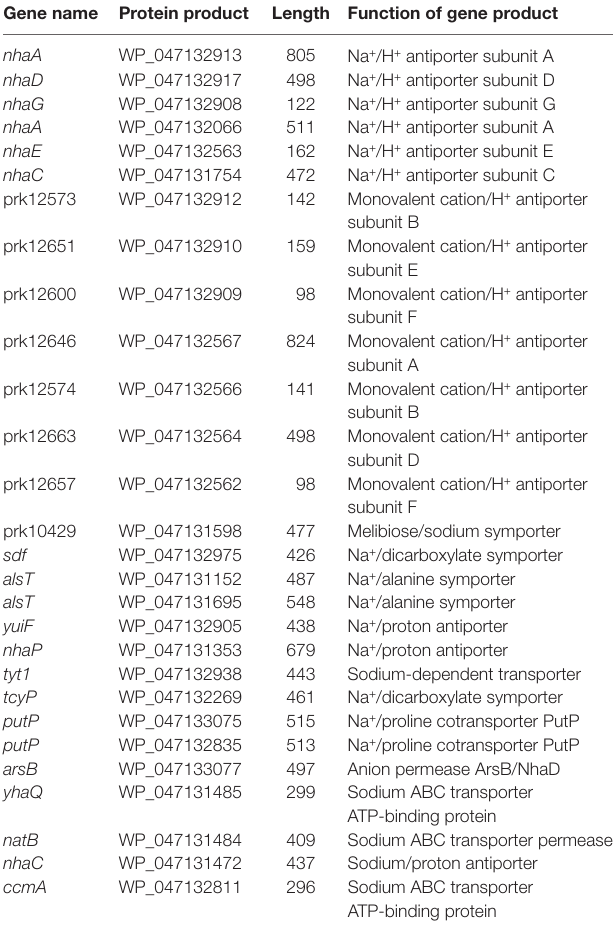
taBLe 1 | Summary of salt-dependent and salt acclimation genes in DSM 11674. Gene name protein product Length Function of gene